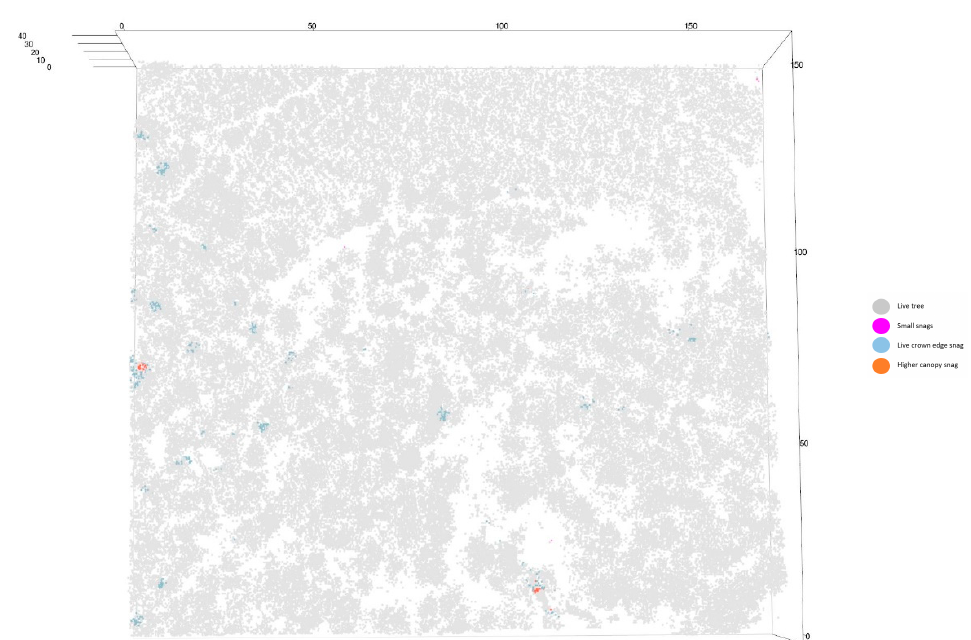
Figure 11. Snags identification and classification (SGTM).